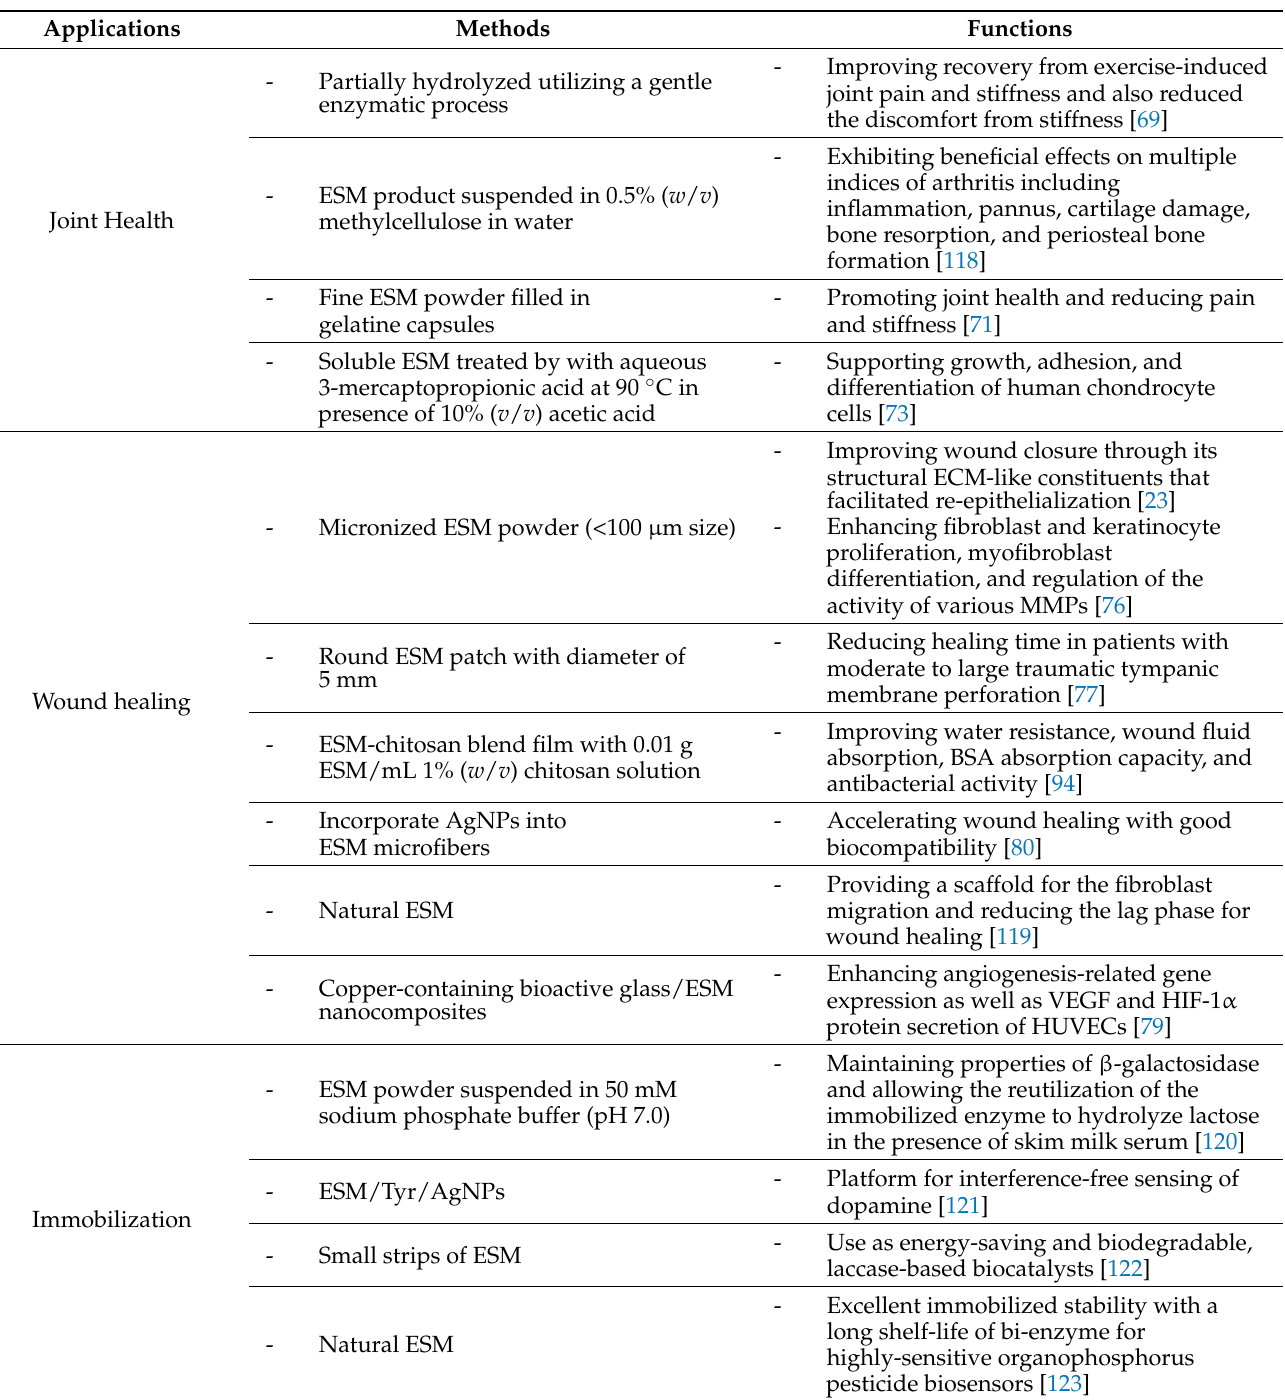
Table 2. Applications of ESM and its corresponding preparation